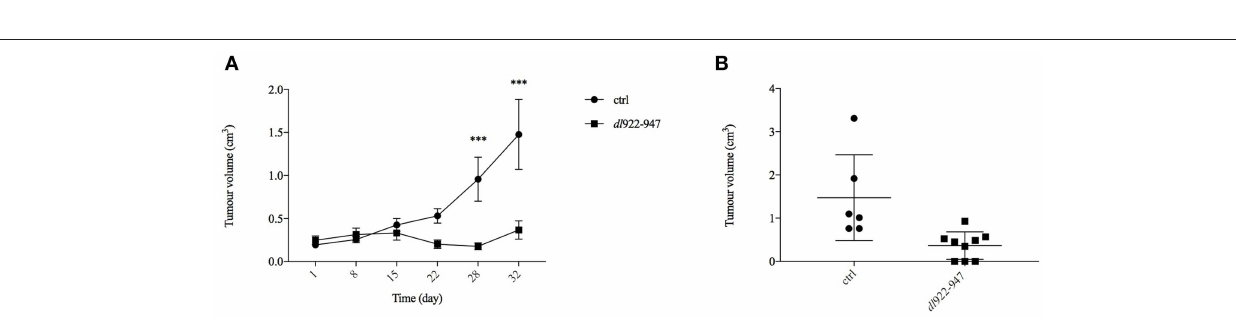
FIGURE 6 | dl 922-947 inhibits the growth of MPM xenografts. Mice were subjected to intra-tumoral injections with dl 922-947 (4 × 10 6 pfu) twice per week for a total of 5 weeks. (A) The days of treatment are reported; a significant difference (*** p < 0.001) in tumor growth was observed at day 28. (B) Dot plot reporting the xenograft volumes at the final endpoint (32nd day of treatment). Three animals from the control group were sacrificed earlier because tumors were either too big or ulcerated, whereas 3 mice in the treated group showed complete tumor